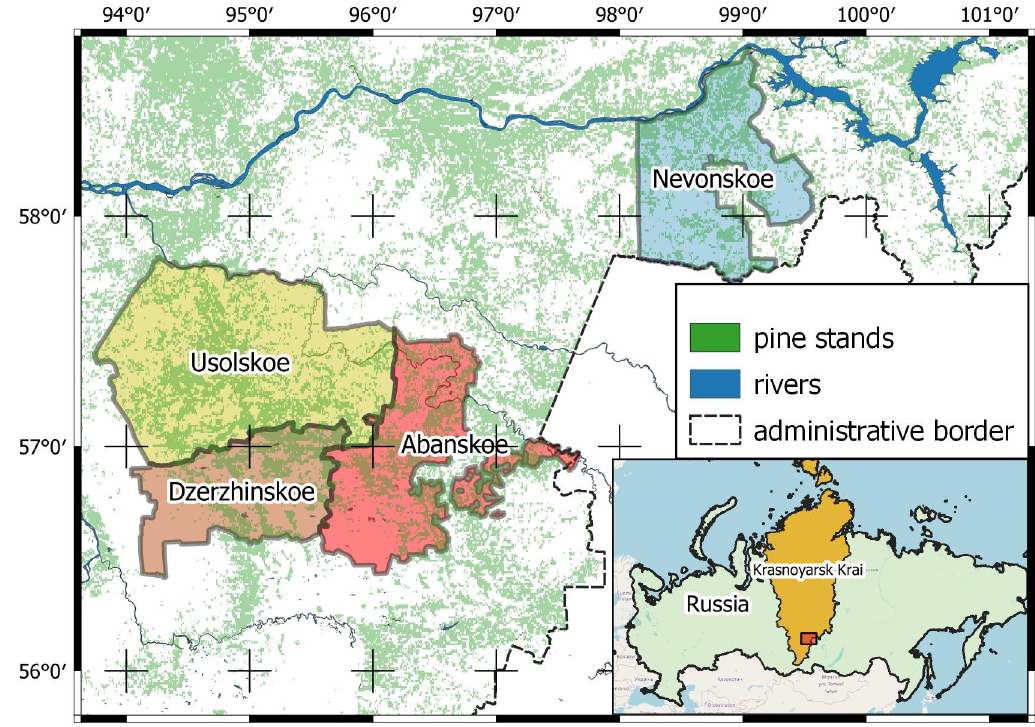
Figure 1. Study area.